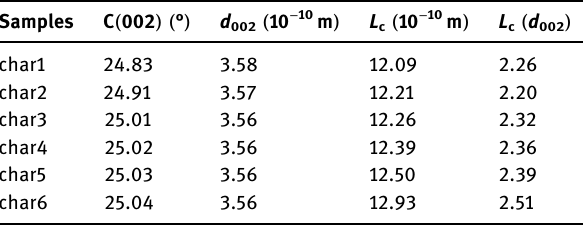
Table 3: Characteristic parameters of microcrystalline structure of semi -